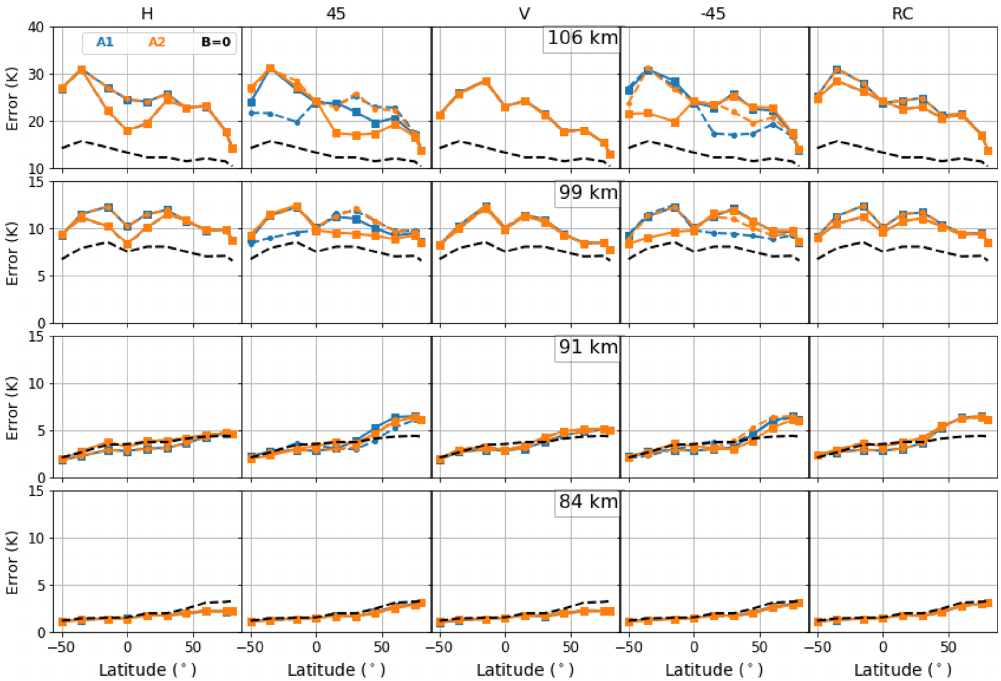
Figure 9. Retrieval errors on the temperature profile induced by the measurement noise, for a radiometer with horizontal (H), 45 ◦ (45), vertical (V) and − 45 ◦ ( − 45) linear polarizations, and right circular (RC) polarization. The colored dashed lines are results for the descending orbit branch while the full lines ones are those for the ascending branch. The blue (yellow) lines show the results for antenna-1 (antenna-2). The black dashed lines show the errors that occur if the Zeeman effect is not considered. Vertical resolution of the retrieved profiles is 2.5km.